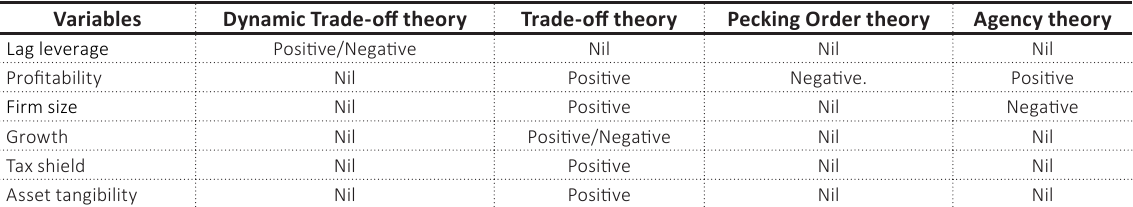
Source: Researcher’s computation